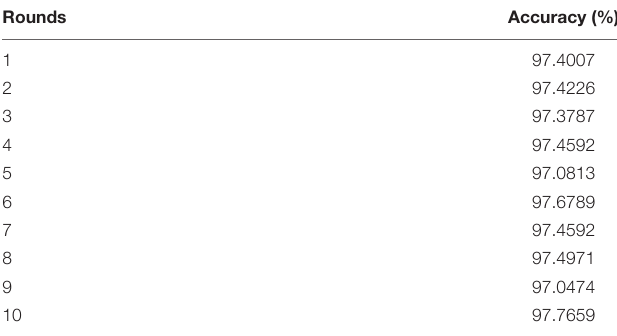
TABLE 2 | Results for 10-fold cross validation.